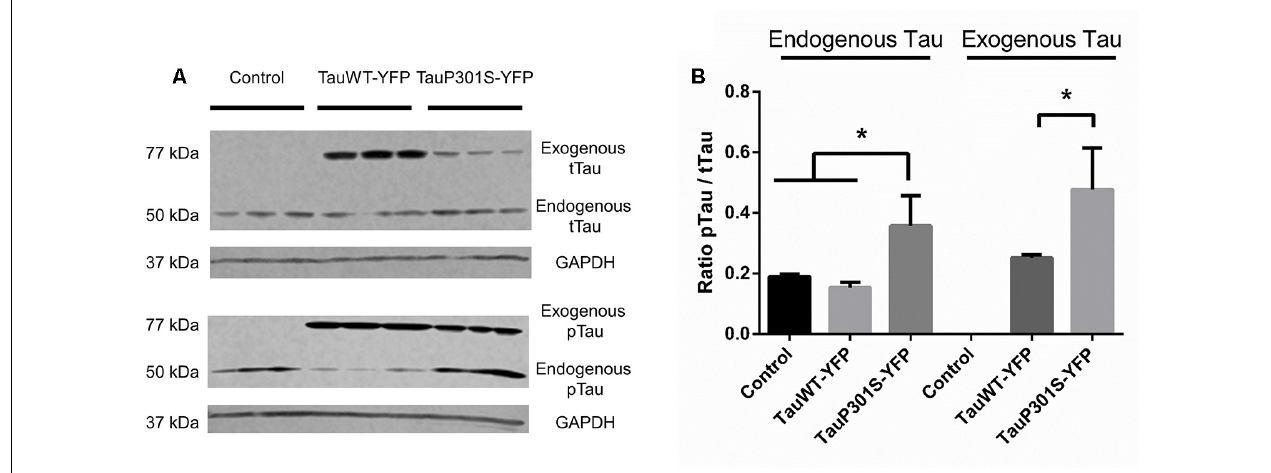
FIGURE 4 | FTD pathological modeling using modified iPSCs expressing an EBV-based plasmid. (A) Western Blot analysis of total tau protein (tTau, TAU5 antibody) and phosphorylated tau protein (pTau, AT8 antibody). The expression of a fusion protein enables the endogenously expressed tau protein to be distinguished from the exogeneous form expressed using the EBV-based plasmid. (B) Ratio of phosphorylated tau protein over total tau against GAPDH for endogenous and exogenous tau. Statistical analysis: one-way analysis of variance (ANOVA; multiple groups). On charts * p <